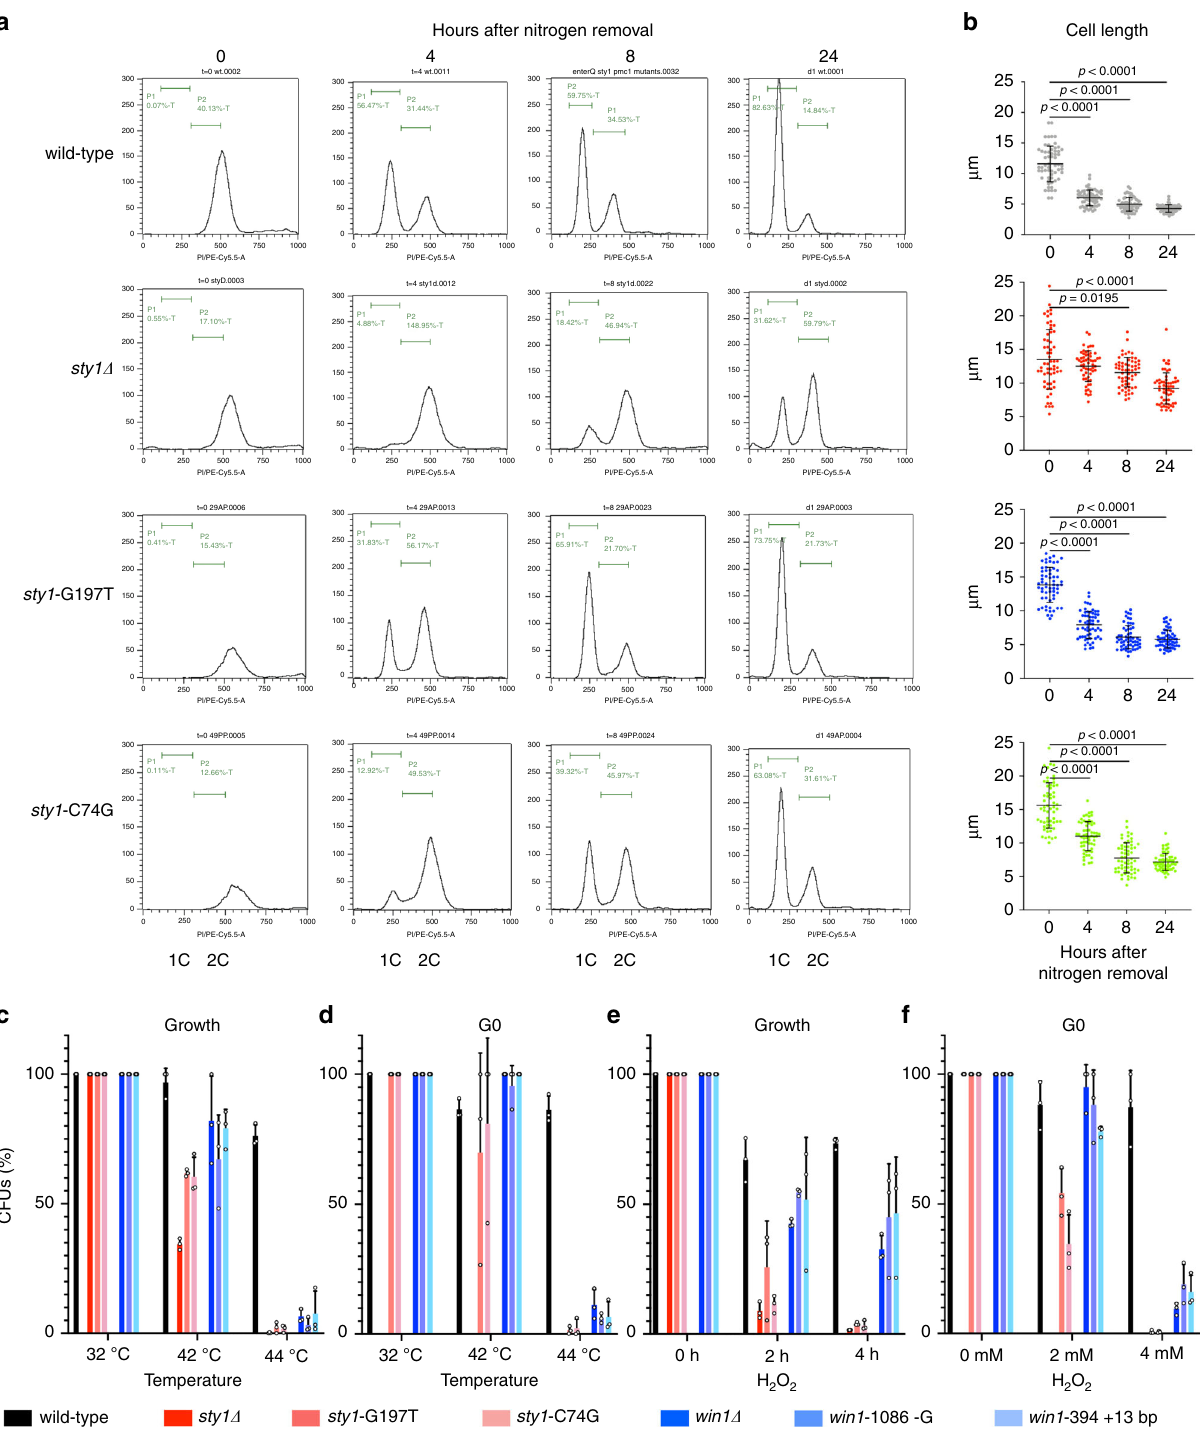
Fig. 4 Analysis of quiescence entry and sensitivity to stress. a DNA content analysis after nitrogen removal was determined by FACS. b Cell size determined with ImageJ on pictures ( n = 60) after nitrogen removal. The mean and SD are depicted. Two-tailed Mann – Whitney tests were applied and only signi fi cant exact p values are shown. Source data are provided as a Source Data fi le. c The growing strains were incubated for 2h at the indicated temperature prior to plating. d Viability of 1-day-old quiescent strains incubated for 2 h at the indicated temperature prior to plating. e Viability of the growing strains following exposure to 1mM H 2 O 2 for the indicated times. f Viability of 1-day-old quiescent strains following exposure for 2 h to the indicated amounts of H 2 O 2 prior to plating. After plating on rich medium and incubating at 32 °C for 3 days, colony-forming units were scored. The values determined at 32 °C, or in the absence of treatment, were set to 100%. The mean, SD, and individual values ( n = 3) are shown. Source data are provided as a Source Data fi